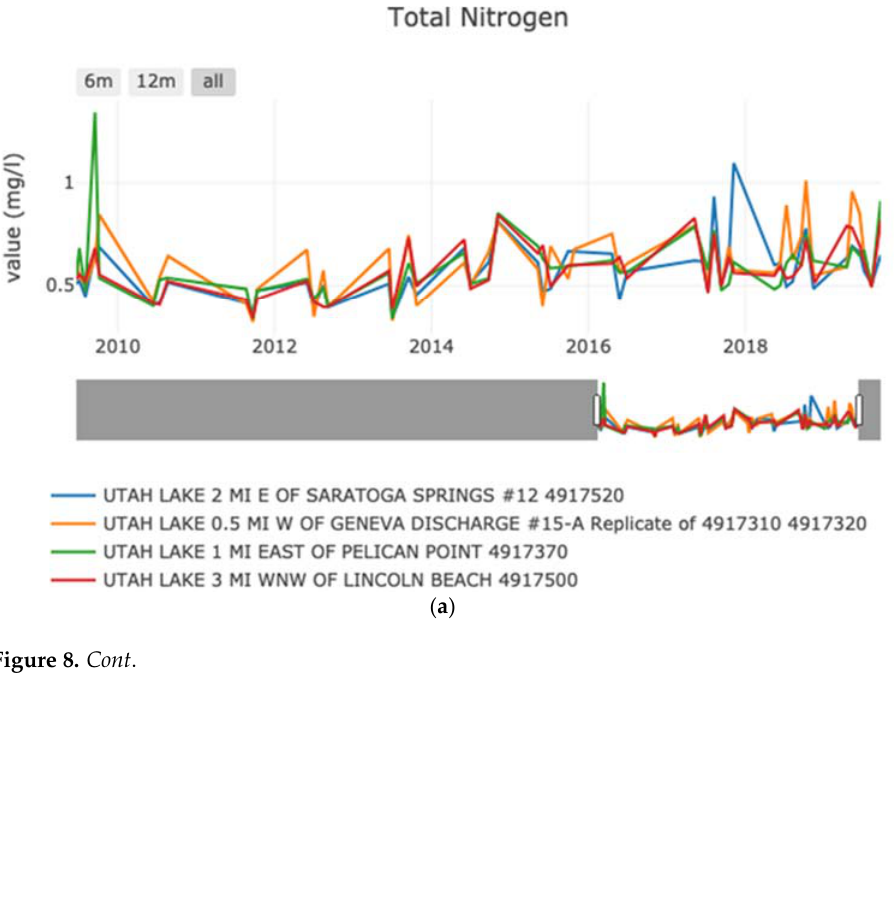
Figure 7. Utah Lake ( a ) All lake stations; ( b ) Stations with Total Nitrogen data from AWQMS.